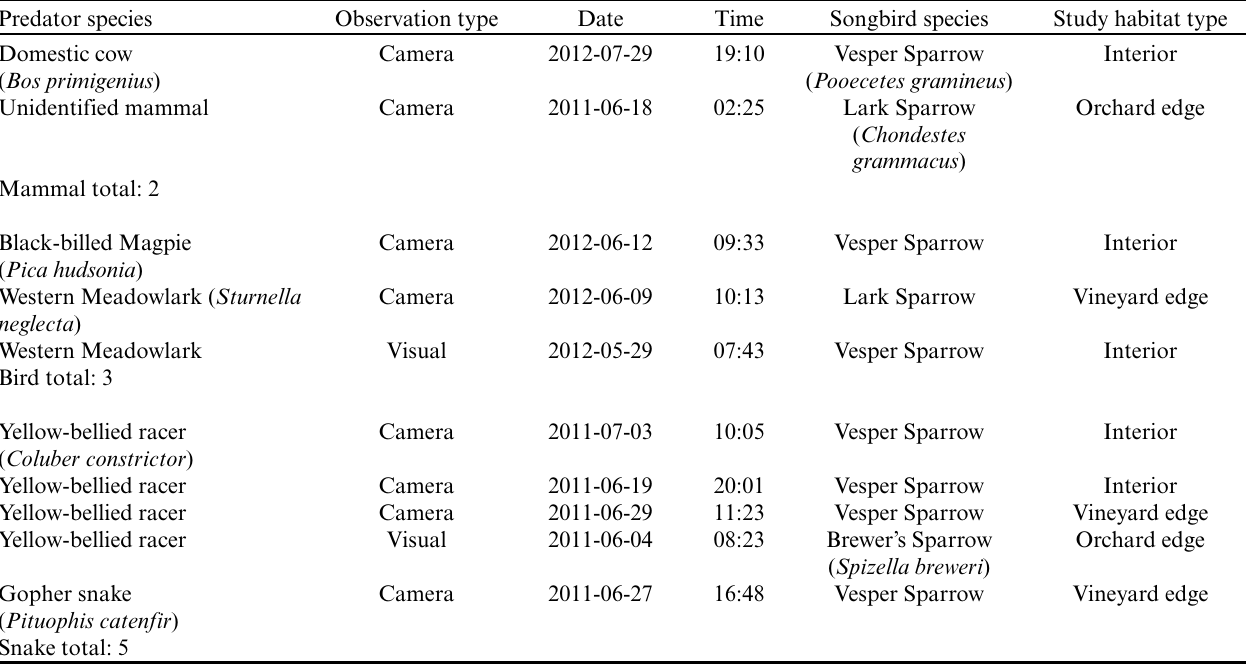
Table 6 . Details of confirmed predation events at songbird nests in sagebrush habitat. Predation events were considered confirmed if recorded by nest camera or visually